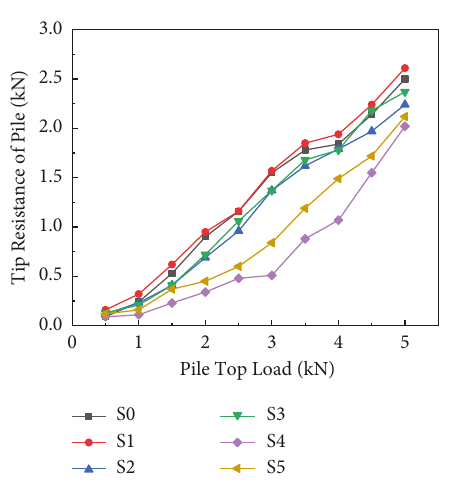
Figure 17: Curve of pile tip resistance and pile top